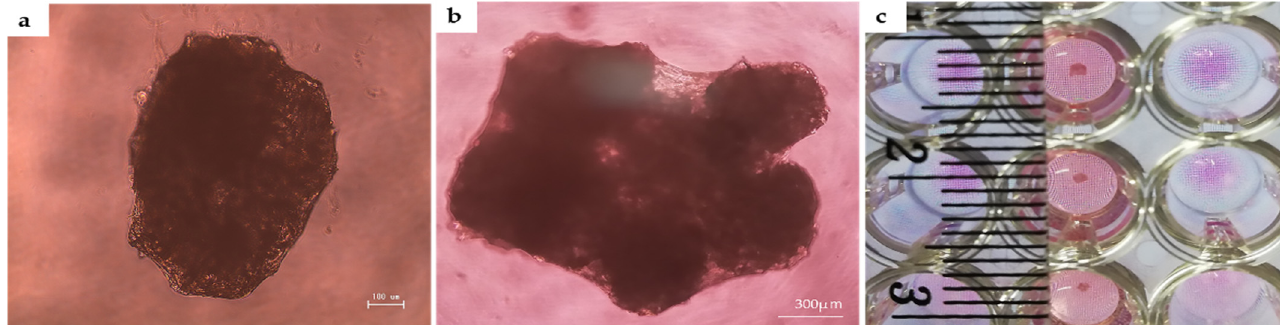
Figure 4. Images of rDPSC-CellSaic under a microscope and after fusion. ( a ) rDPSC-CellSaic image (Scale bar = 100 µm); ( b ) After fusion with eight CellSaics (Scale bar = 300 µm); ( c ) Visual observation of the fused CellSaic.